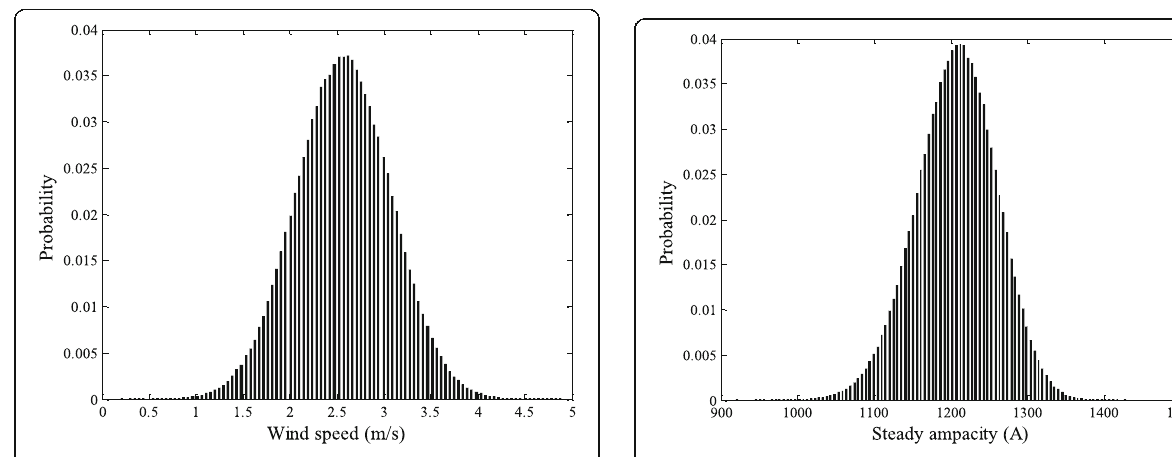
Fig. 8 CIGRE standard DTR